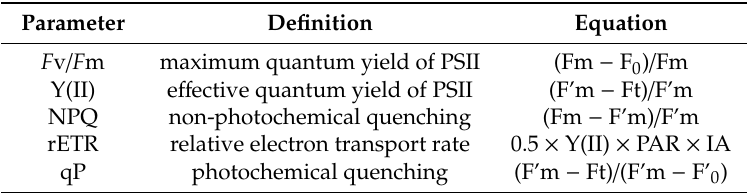
Table 3. Fluorescence parameters calculated from PAM in Ulva prolifera after